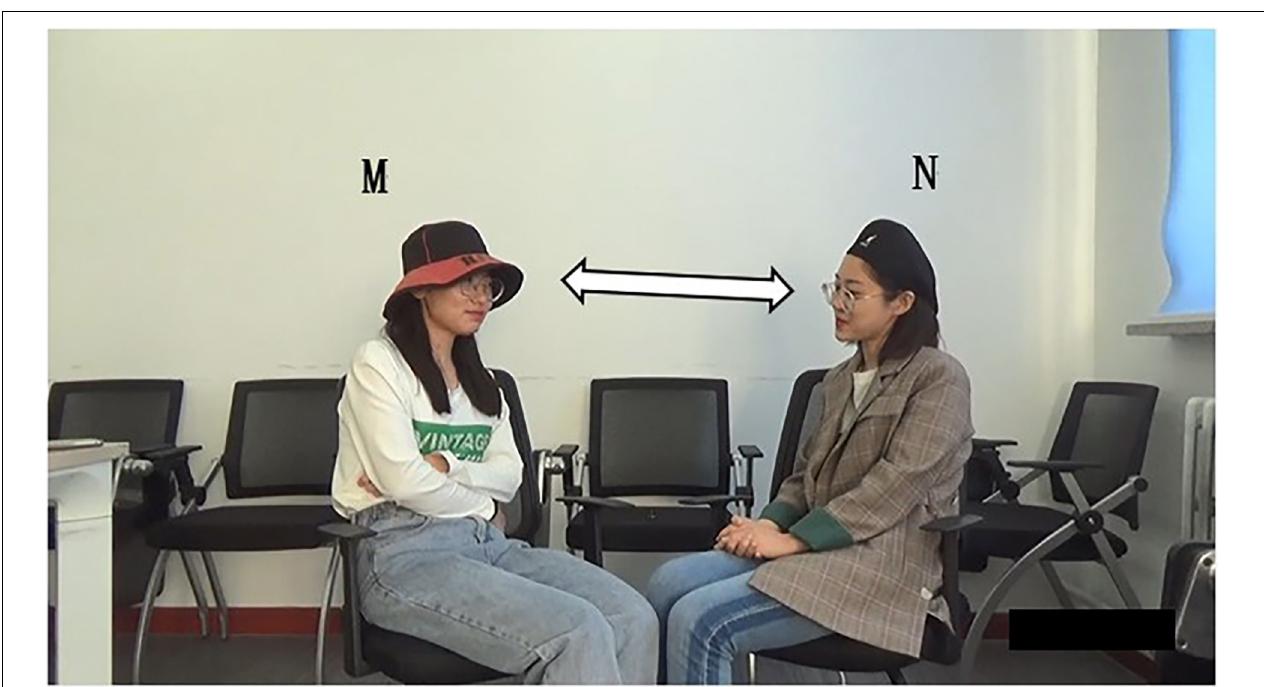
FIGURE 9 | Bodily movement of N in self-selection in line